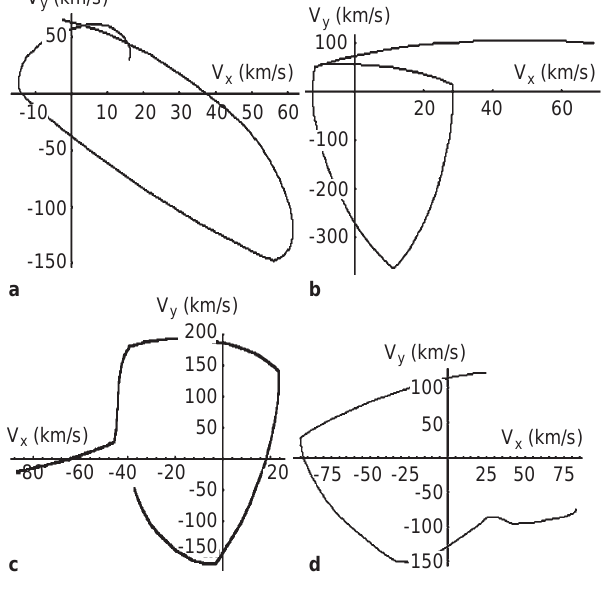
Fig. 8a–d. Hodographs of the plasma flow velocity (km/s) in the GSM coordinates for the selected time intervals with the dissimilar-